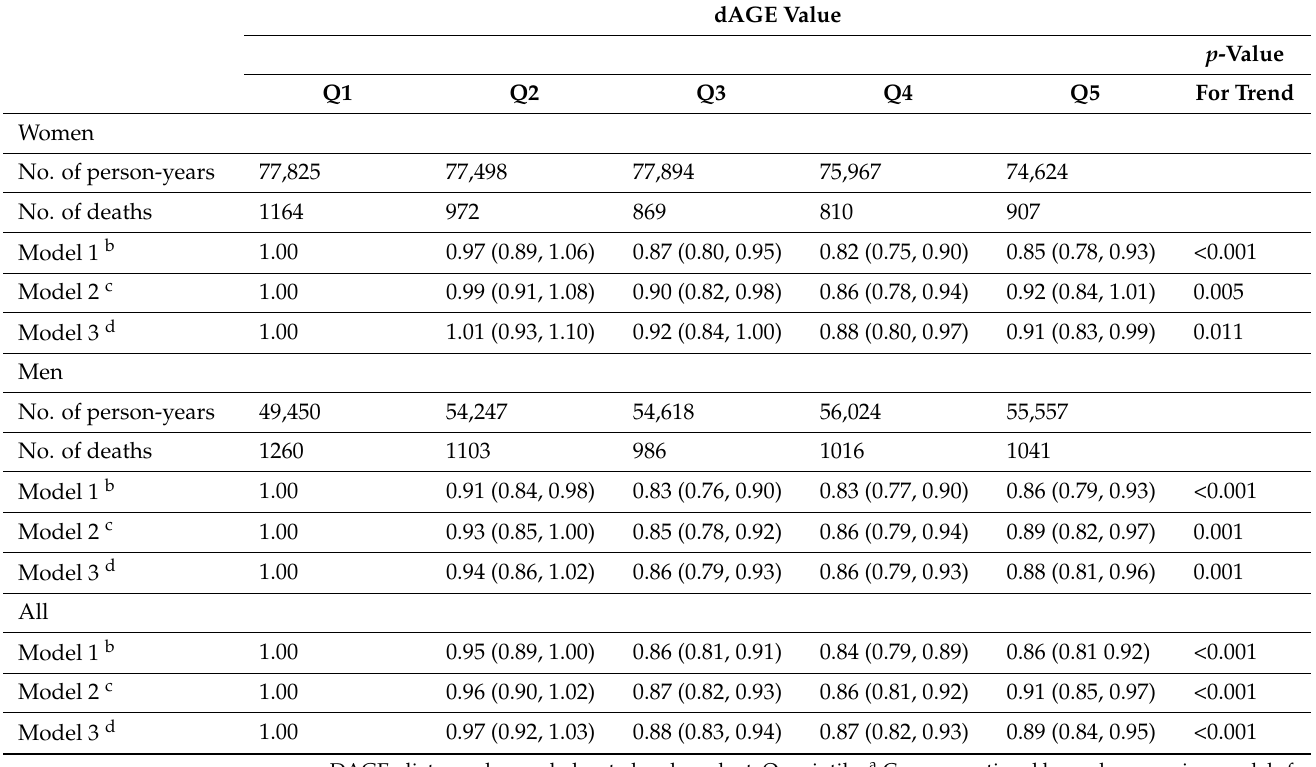
Table 2. Hazard ratios for all-cause mortality, according to the dAGE quintiles a